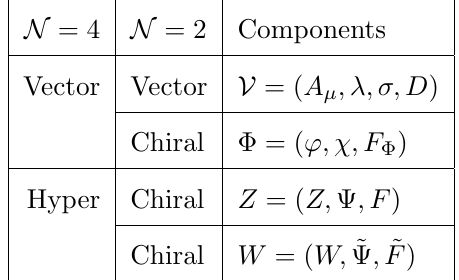
= 4 and = 2 multiplets in three N N